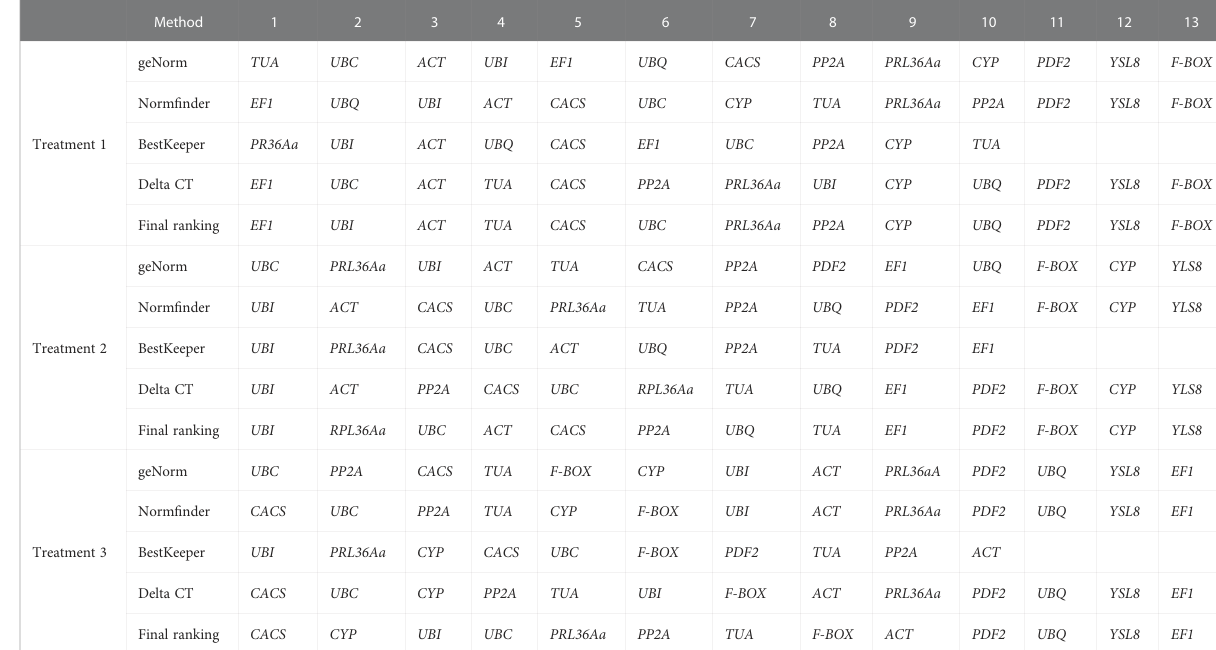
TABLE 4 Ranking order of candidate reference genes in all samples in cucumber